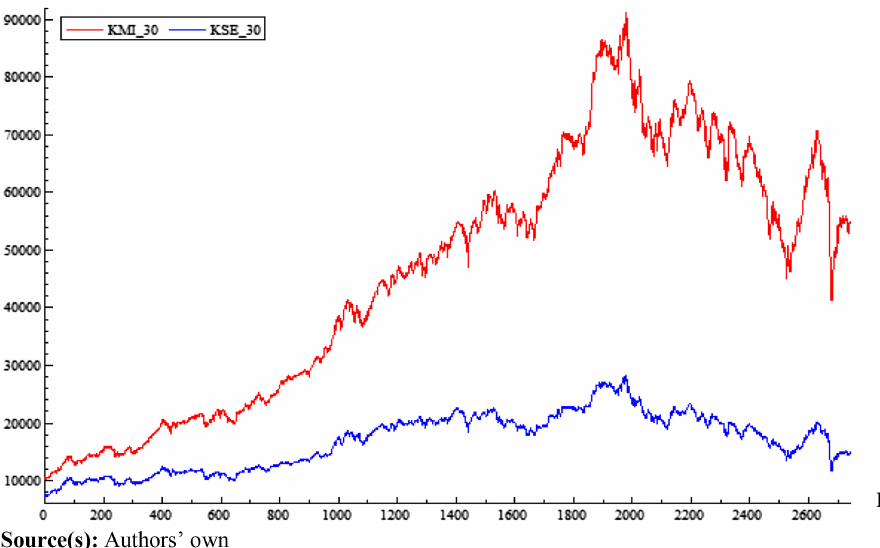
Figure 1. Daily prices of